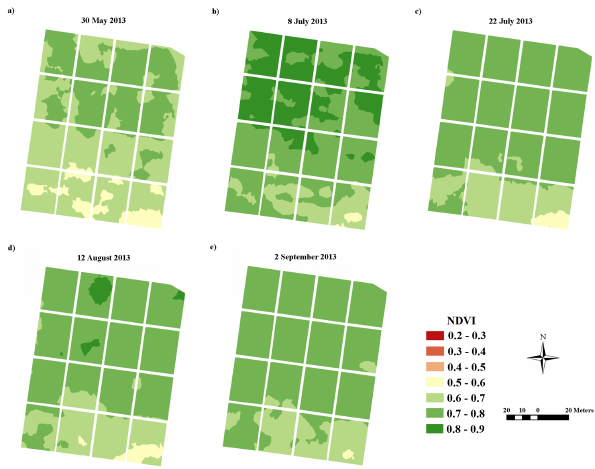
Figure 9. NDVI maps year 2013: (a) 30 May; (b) 8 July; (c) 22 July; (d) 12 August; and (e) 2